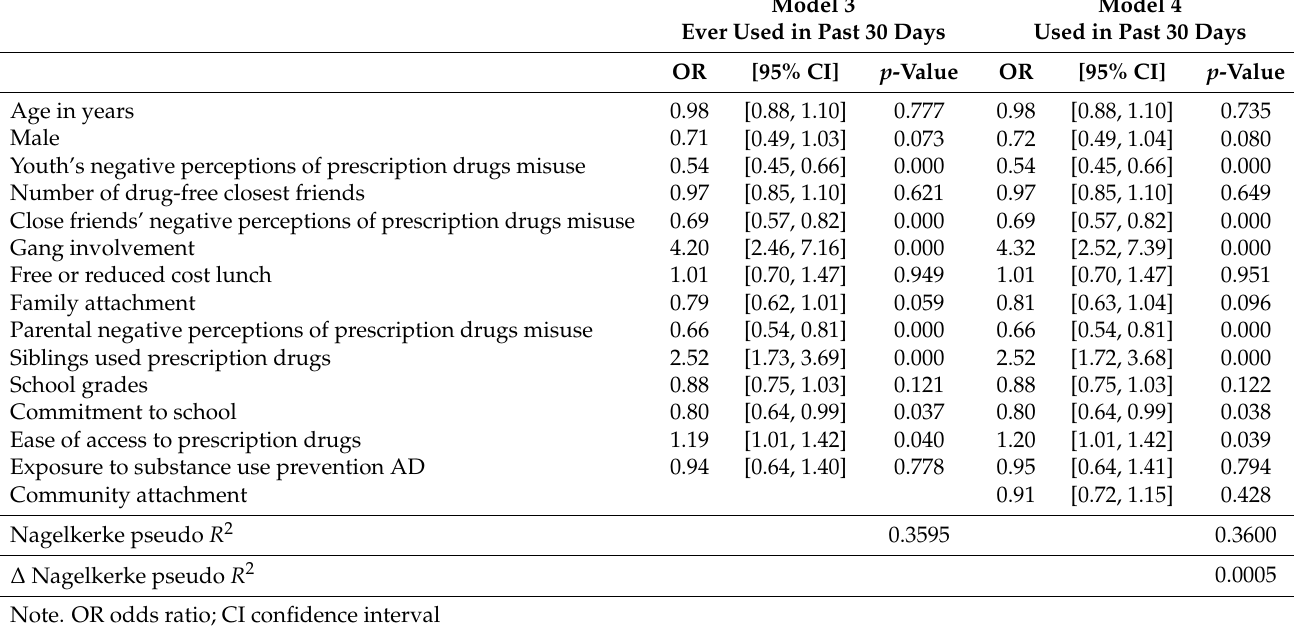
Table 3. Logistic regression results for American Indian youth past-30-days prescription drug misuse (N =